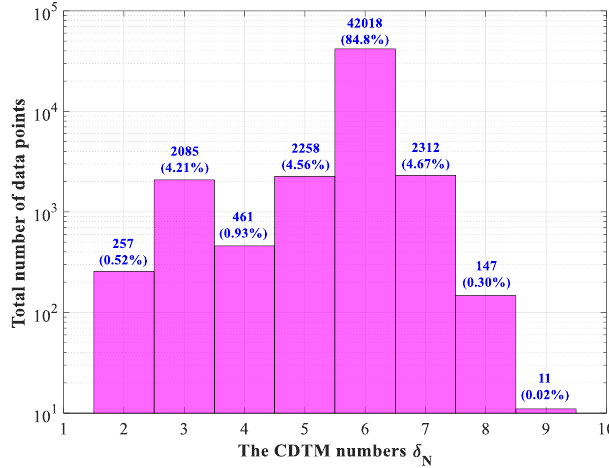
Figure 10. The adopted involute cylinder gear and its generated DTMs.